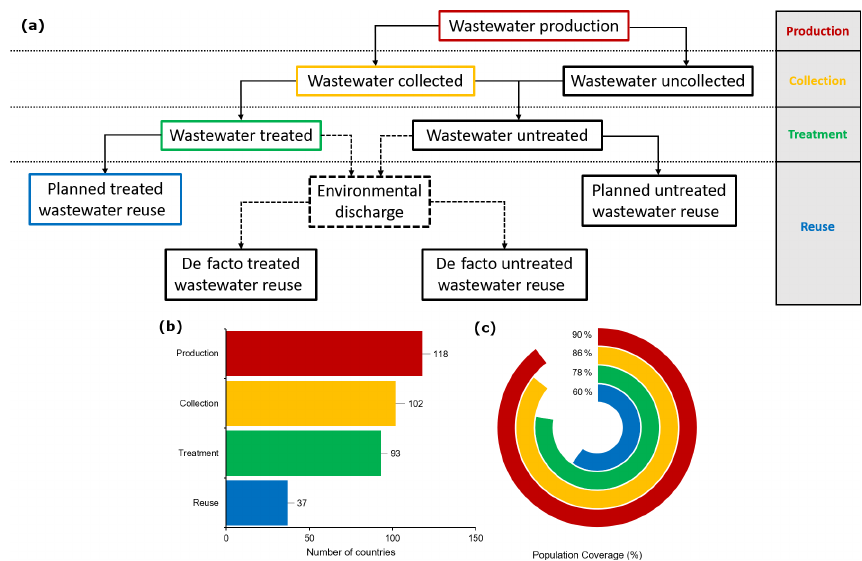
Figure 1. The wastewater chain (a) , including wastewater data availability with number of countries for which wastewater data are available (b) and the percentage of population coverage (i.e. the proportion of the global population for which wastewater data are available) (c) .